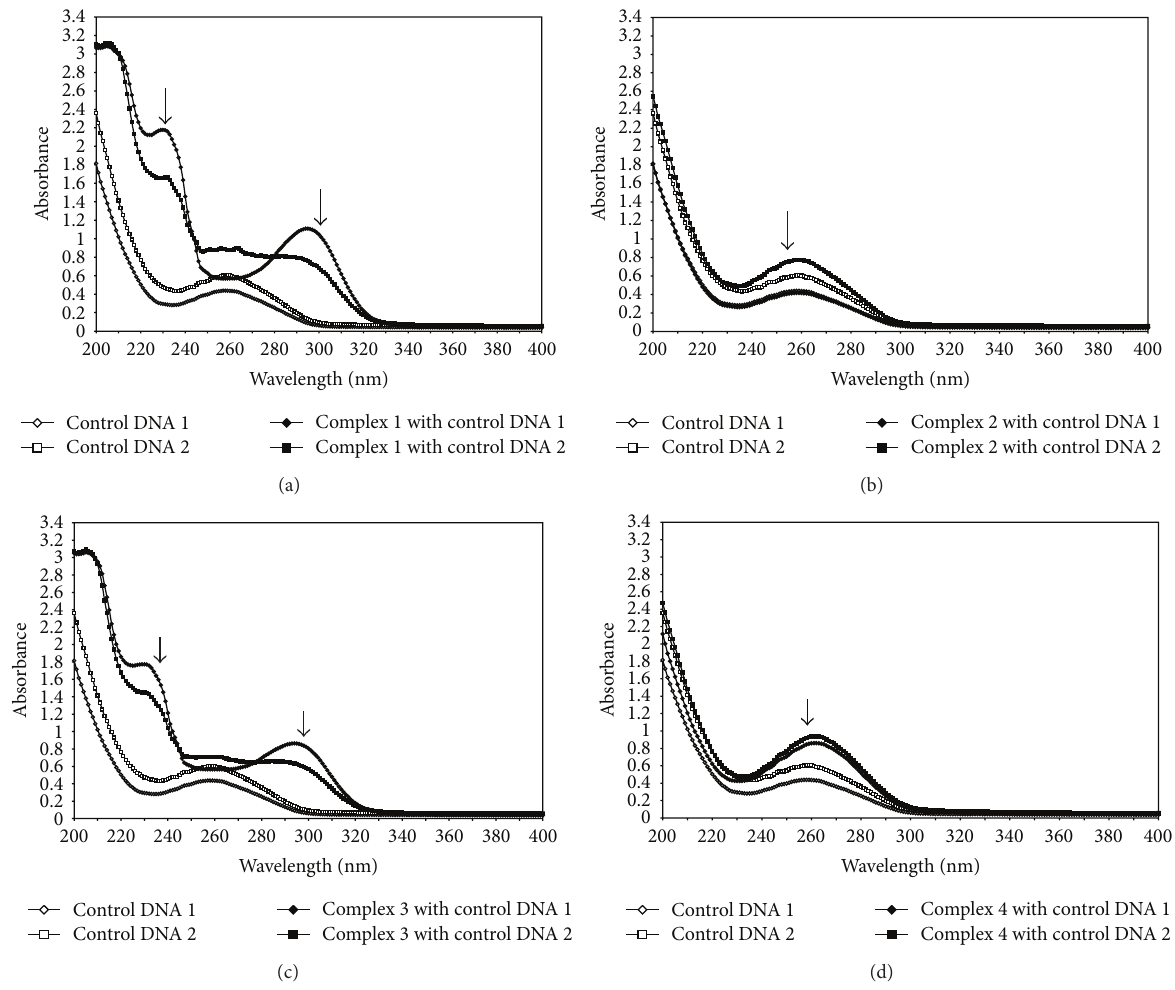
Figure 1: (a) Electronic absorption spectra of complex 1 (100 𝜇 M) with increasing amounts of DNA 1 (11.2 𝜇 g) and DNA 2 (22.5 𝜇 g). (b) Electronic absorption spectra of complex 2 (100 𝜇 M) with increasing amounts of DNA 1 (11.2 𝜇 g) and DNA 2 (22.5 𝜇 g). (c) Electronic absorption spectra of complex 3 (100 𝜇 M) with increasing amounts of DNA 1 (11.2 𝜇 g) and DNA 2 (22.5 𝜇 g). (d) Electronic absorption spectra of complex 4 (100 𝜇 M) with increasing amounts of DNA 1 (11.2 𝜇 g) and DNA 2 (22.5 𝜇 g). Arrows show the changes in absorbance with respect to an increase in DNA